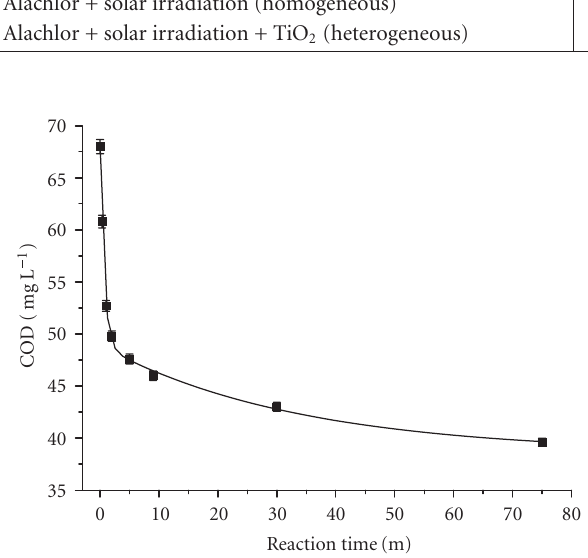
Figure 4: COD abatement of a solution of 0 . 267 mmol L − 1 alachlor as a function of solar irradiation time. ( (cid:2) ) corresponds to the exper- imental data. (—) corresponds to a plot obtained from the best fit of the experimental data using the exponential decay second-order